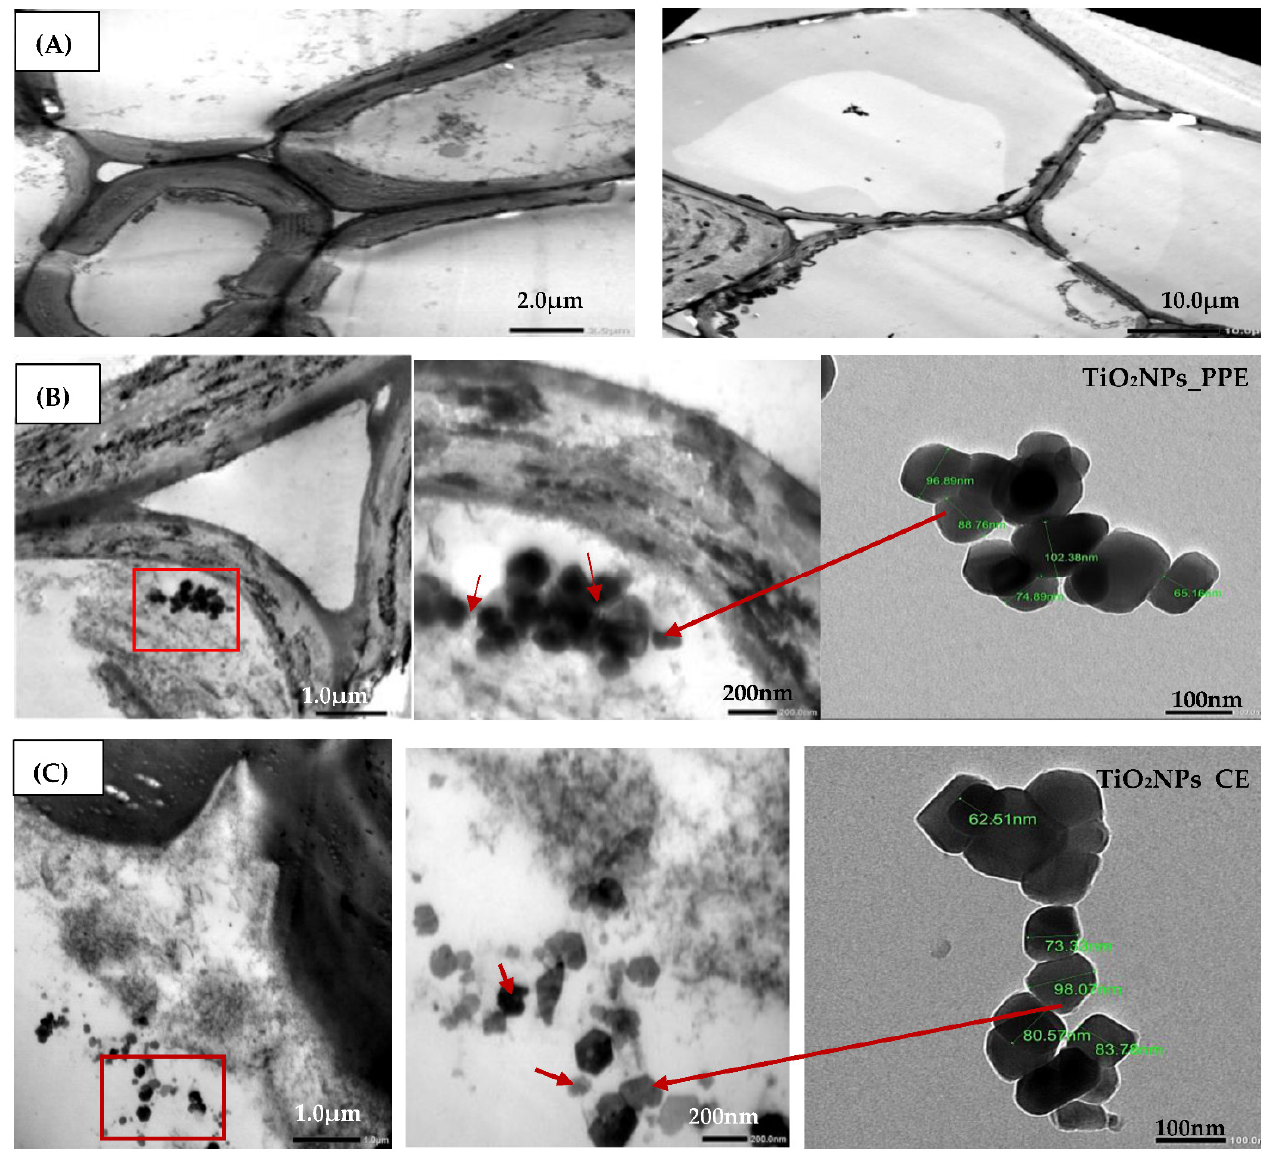
Figure 6. TEM images of seeds of P. granatum treated with 40 mg/L TiO 2 NPs suspension for 24 h., demonstrating cross-sections of seeds after priming by: ( A ) distilled water (hydroprimed), ( B ) TiO 2 NPs_PPE and ( C ) TiO 2 NPs_CE. Details of the clusters constituted by Ti dioxide nanoparticles inside seed tissue are in the same pattern as revealed by the TEM image of synthesized NPs. (Red boxes and arrows indicate the detected TiO 2 NPs).